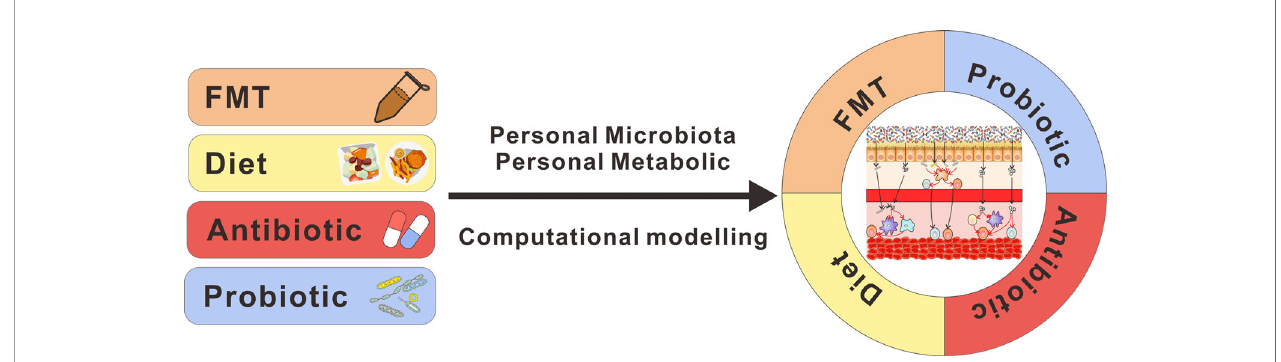
FIGURE 2 | Design of microbial therapeutics to bene fi t cancer immunotherapy. Stable microbial engraftment is manipulated by intrinsic microbiota, extrinsic nutrients, and colonic metabolic. As a tool, computational modeling can be used to predict the engraftment of microbiota members. Thus, with the deeper insight into this fi eld, the rational design of microbial therapeutics will take all of those factors into consideration and combine those individual therapeutic strategies to improve